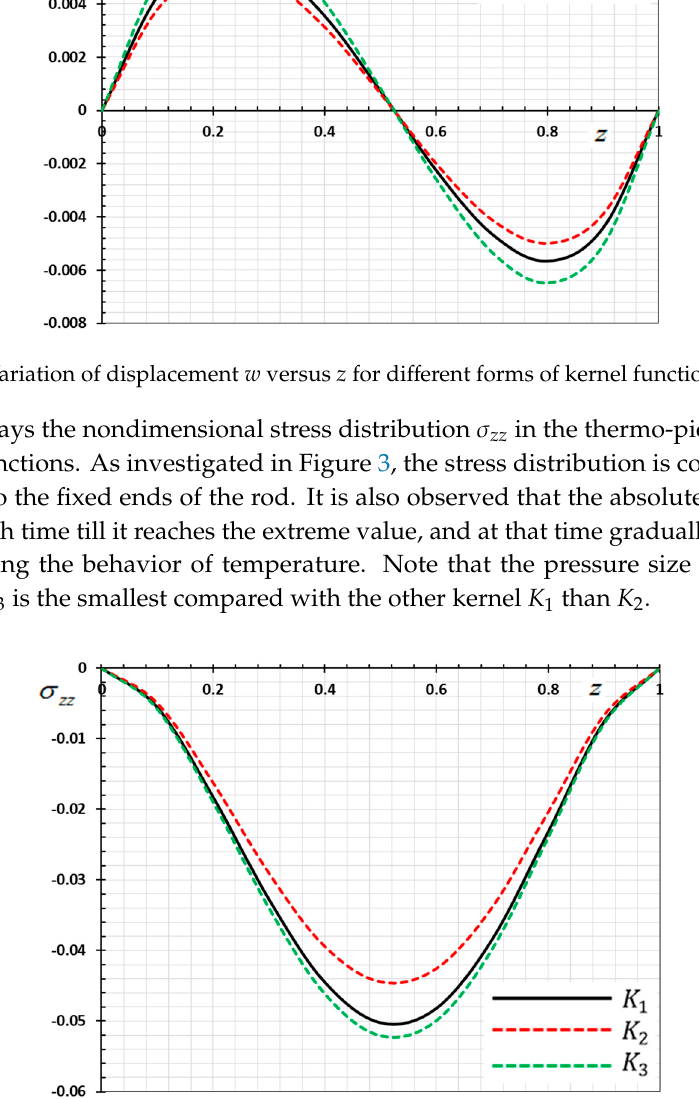
Figure 1. Variation of temperature 𝜃 versus 𝑧 for different forms of kernel function 𝑘(𝑡 − 𝜉) .